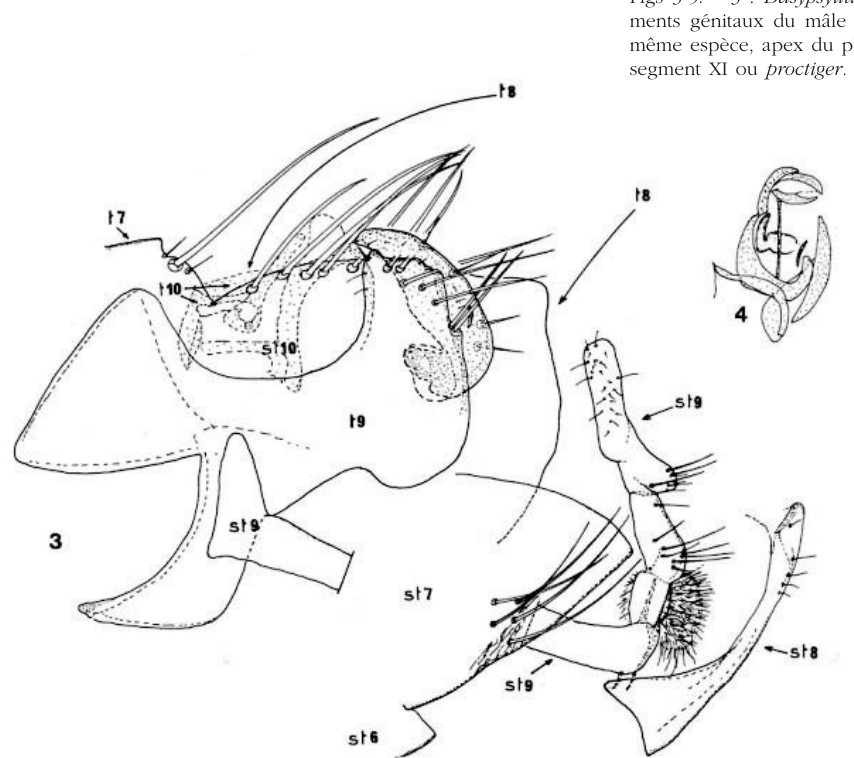
Figs 1, 2. – 1 : Dasypsyllus (Neornipsyllus) huinayensis sp. n., seg- ments génitaux du mâle (t = tergite; st = sternite); 2 : même espèce, apex du phallosome ( aedeagus ). Figs 3-5. – 3 : Dasypsyllus (Neornipsyllus) tapaculensis sp. n, seg- ments génitaux du mâle (mêmes abréviations que ci-dessus); 4 : même espèce, apex du phallosome ( aedeagus ); 5 : même espèce, segment XI ou